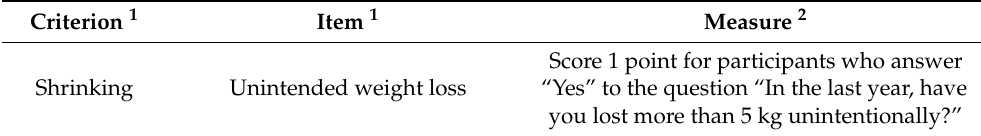
Table 1. The measurement of frailty in the